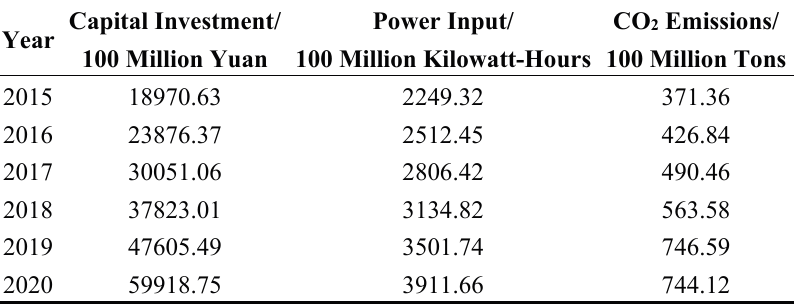
Table 6. Predicted values of the capital investment, power input and CO 2